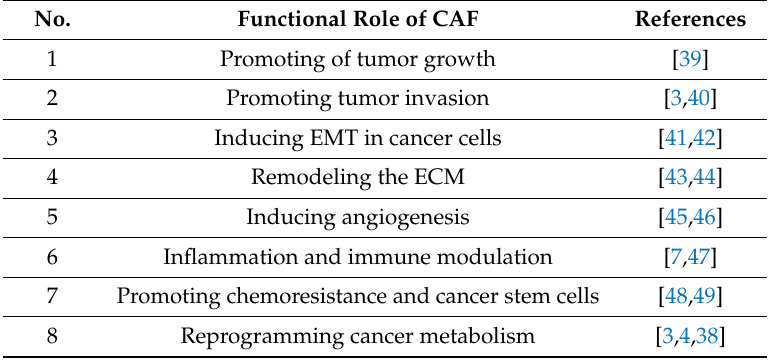
Table 1. Functional roles of cancer associated fibroblasts (CAFs) in tumor progression.